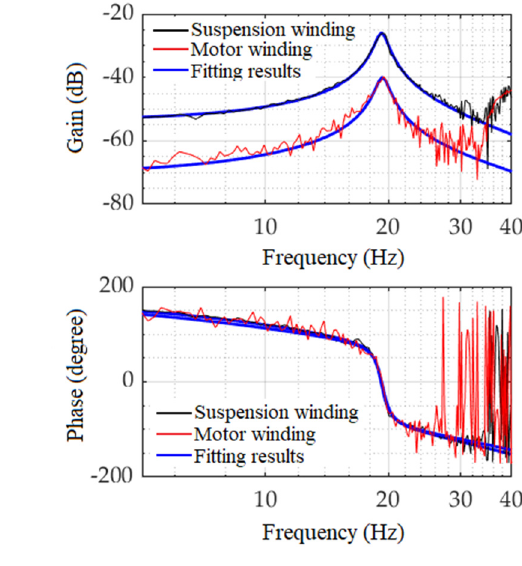
Figure 11. Rotational speed with and without injection of the alternating d-axis current. We assumed that the dynamic parameters of the bearings are constant over a small range of excitation frequencies. For example, the amplitude and phase information at 22